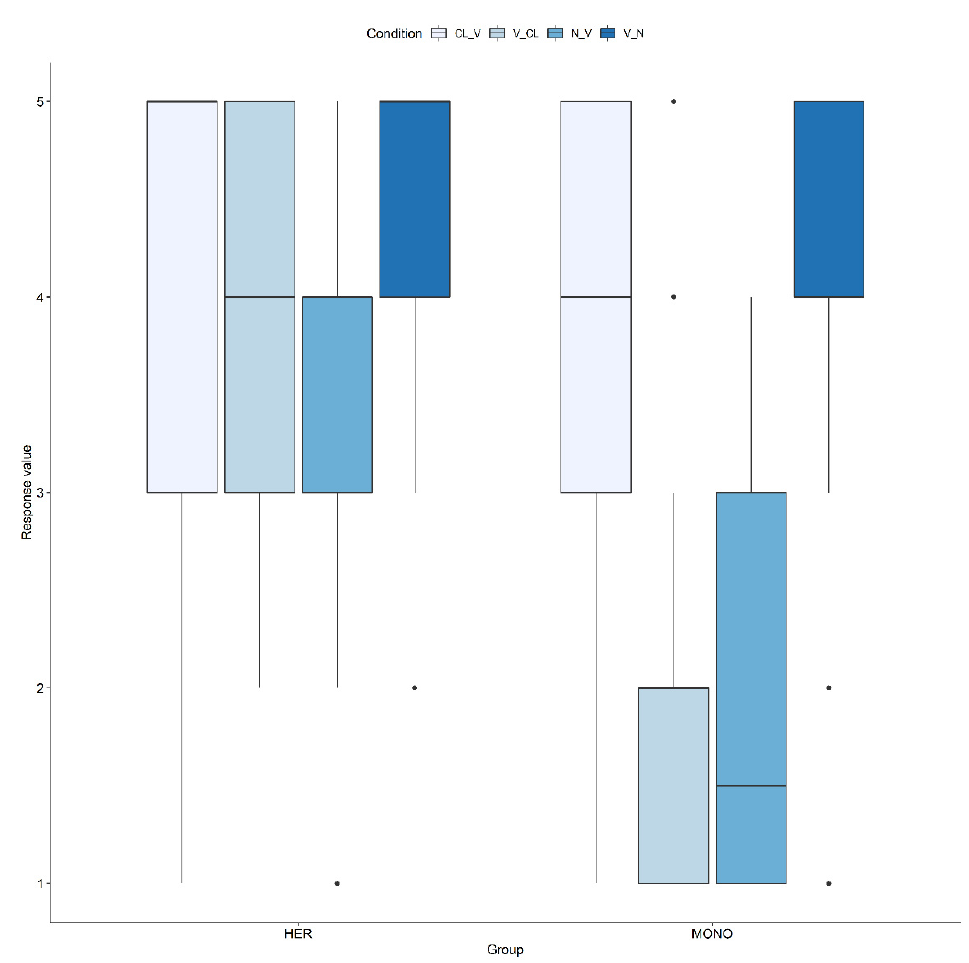
Figure 3. HS and baseline ratings of object clitics and NPs. Table 5. Means of heritage and baseline ratings of clitics and NPs.